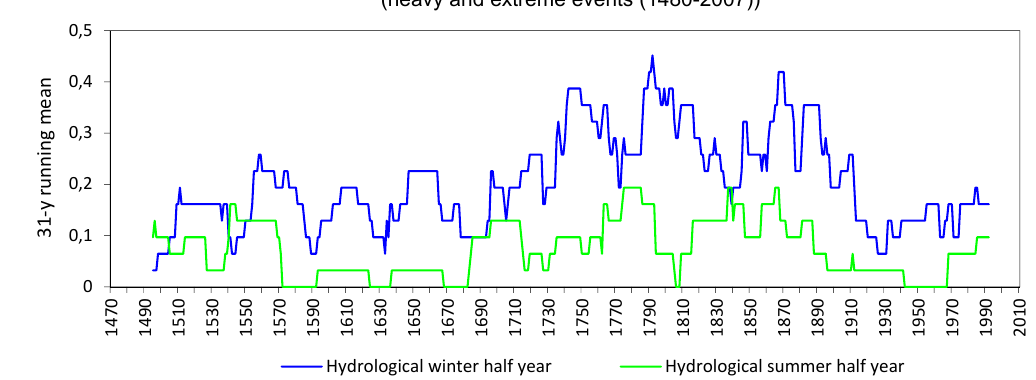
Figure 11. Floods of the River Ill (Alsace) in the hydrological summer and winter years (big and extreme events).